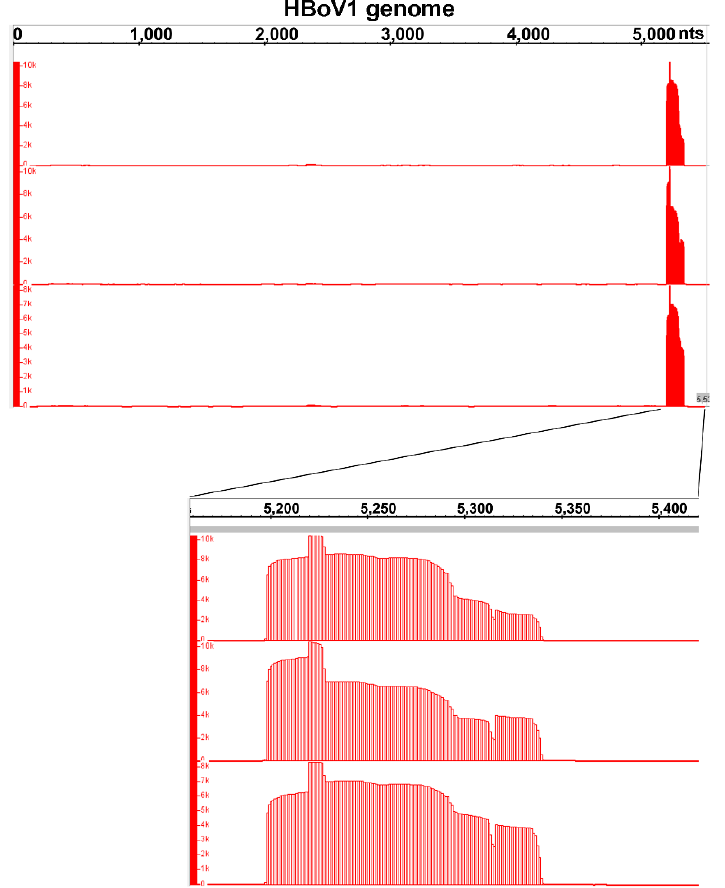
Figure 5. Coverage plots of viral small RNA-seq reads mapped to the HBoV1 genome. The small RNA-seq reads of three HBoV1-infected RNA samples are mapped to HBoV1 genome. Histograms show the frequency of small RNA reads that have the coverage across the HBoV1 genome. The reads coverage of the right ends (nt 5150–5400) of the HBoV1 genome are enlarged for detailed information, show as histograms at the bottom. Table 4. Top 20 identified small RNAs by small RNA-seq.